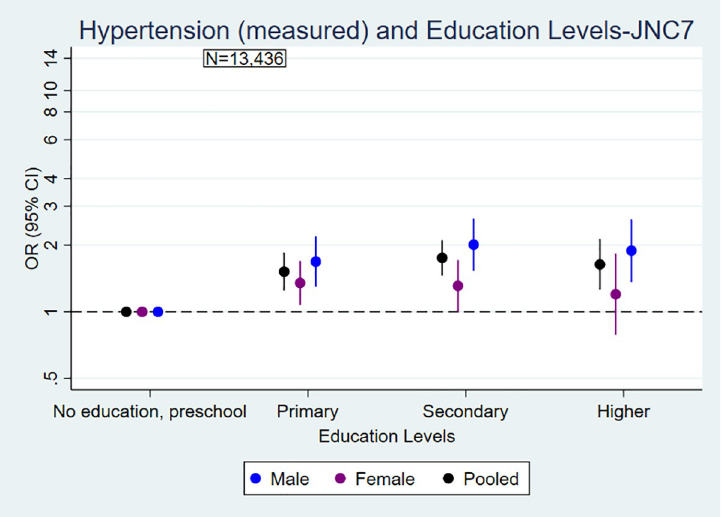
Fig 1. Association of (a) hypertension and (b) normal blood pressure (measured) with education levels by sex in Nepal. a) Hypertension and Education Levels b) Normal Blood Pressure and Education Levels. Odds ratios are adjusted for age, urbanity and marital status, and stratified by sex. Measurement-only outcomes are defined based on cut-off points: hypertension: SBP � 140mmHg or DBP � 90mmHg; normal blood pressure: SBP � 120mmHg and DBP � 80 mmHg.